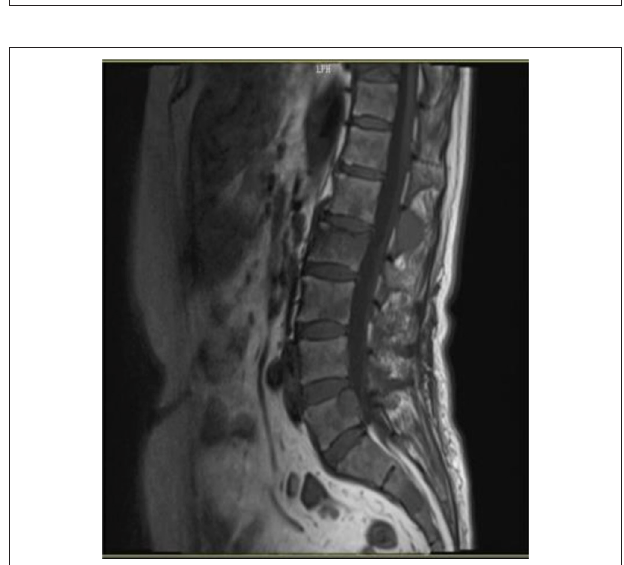
FIGURE 2 | Lumbar MRI prompted lumbar vertebra multiple bone